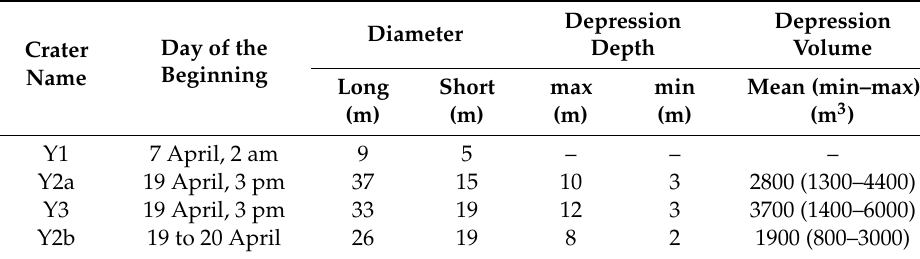
Table 1. Topographical values of Ioyama-south craters.